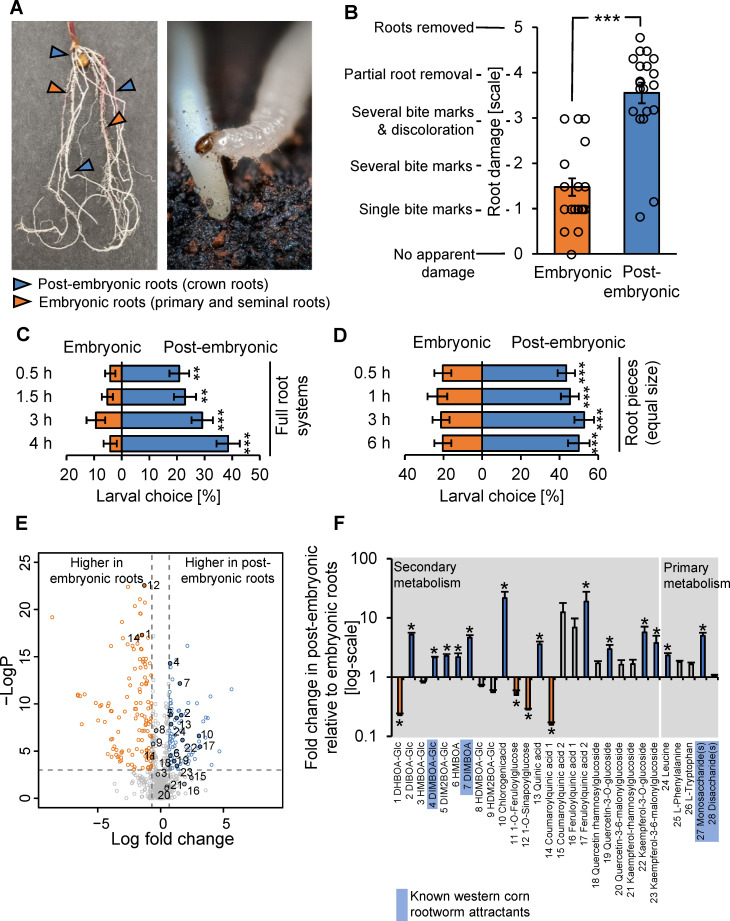
The western corn rootworm prefers to feed on root tissues that are rich in benzoxazinoids and soluble sugars.(A) Left: Young maize plants produce embryonic primary and seminal roots (orange arrows) and postembryonic crown roots (blue arrows). Right: Western corn rootworm larvae are highly specialized maize root feeders that are very mobile in the second and third instar. A third instar larvae is shown. (B) Average damage score observed on postembryonic and embryonic roots of soil-grown maize plants after 7 days of infestation by western corn rootworm larvae (***p < 0.001, Wilcoxon Signed Rank test, n = 20 plants with 15 larvae each, data from Fig 4D). Dots represent damage scores on individual plants (averaged within root types). For frequency distributions of individual roots, refer to S1 Fig. (C) Preference of western corn rootworm larvae for postembryonic and embryonic roots within the root system (**p < 0.01, ***p < 0.001, FDR-corrected Least Square Mean post hoc tests, n = 16 dishes with 6 larvae each). (D) Preference of western corn rootworm larvae for root pieces of equal size of postembryonic and embryonic roots (***p < 0.001; FDR-corrected Least Square Mean post hoc tests, n = 18 dishes with 5 larvae each). (E) Metabolomics profiles of methanolic extracts of postembryonic and embryonic roots. Orange features are more abundant in embryonic roots, blue features are more abundant in postembryonic roots (min. 2-fold difference, p < 0.05, FDR-corrected Student t tests, n = 9–10). Numbers denote features that were tentatively assigned to structures based on exact mass and fragment information (S1 Table). (F) Relative abundance differences of tentatively identified metabolites between postembryonic and embryonic roots (fold change of peak areas; *p < 0.05, FDR-corrected Student t tests, n = 9–10). Error bars denote SEM. Underlying data can be found in S1 Data. FDR, false discovery rate; SEM, standard errors of means. Picture credits: Ricardo Machado, Lingfei Hu, Cyril Hertz.